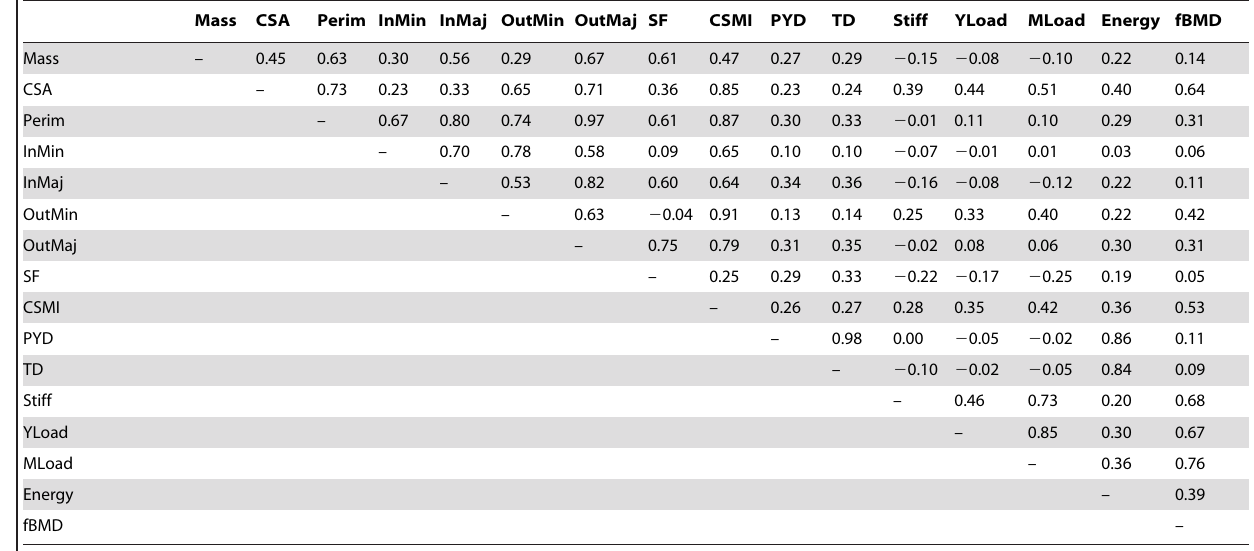
Table 5. Correlations among phenotypes.